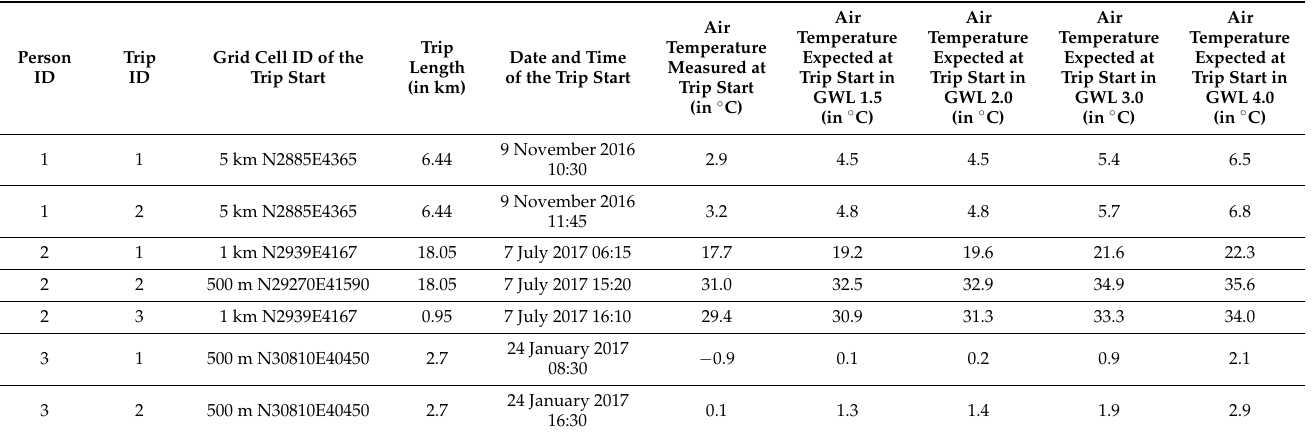
Table 1. Excerpt from the trip data